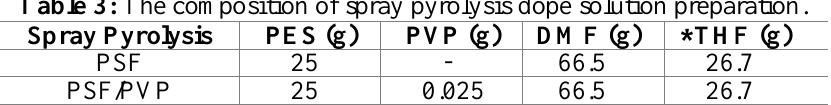
Table 3: The composition of spray pyrolysis dope solution